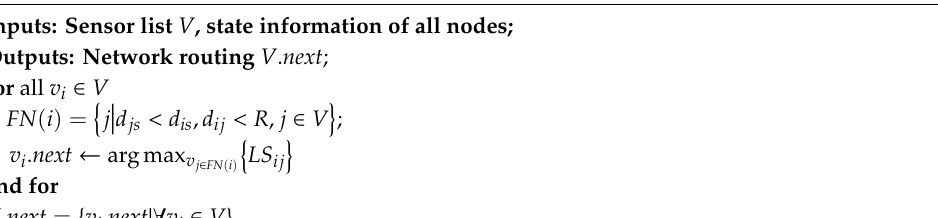
Algorithm 3. Routing setup and update strategy of the autonomous load regulation mechanism-based energy balanced routing algorithm—non radius control (ALRMR-NRC)